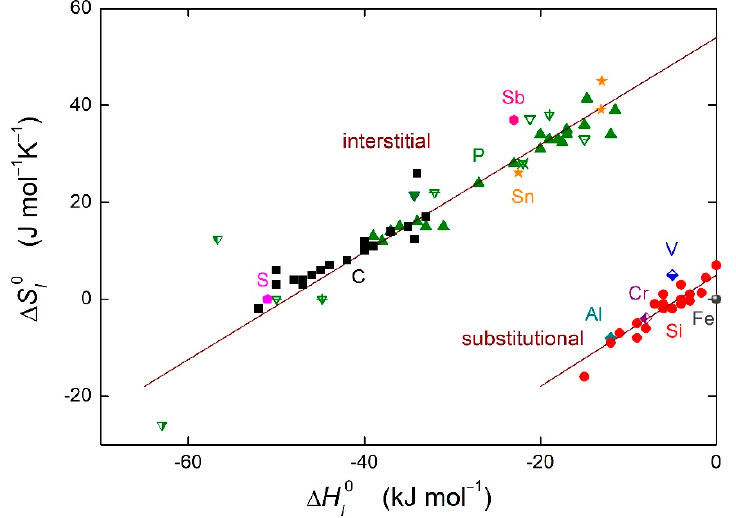
Figure 3. Enthalpy-entropy compensation effect for solute segregation in α -iron. Solid symbols: defined grain boundaries in bicrystals [14], with permission from © IOP Publishing. Other symbols: grain boundaries in polycrystals (data summarized in Reference [1]). Upper branch represents interstitial segregants in α -iron, bottom branch represents substitutional segregation.